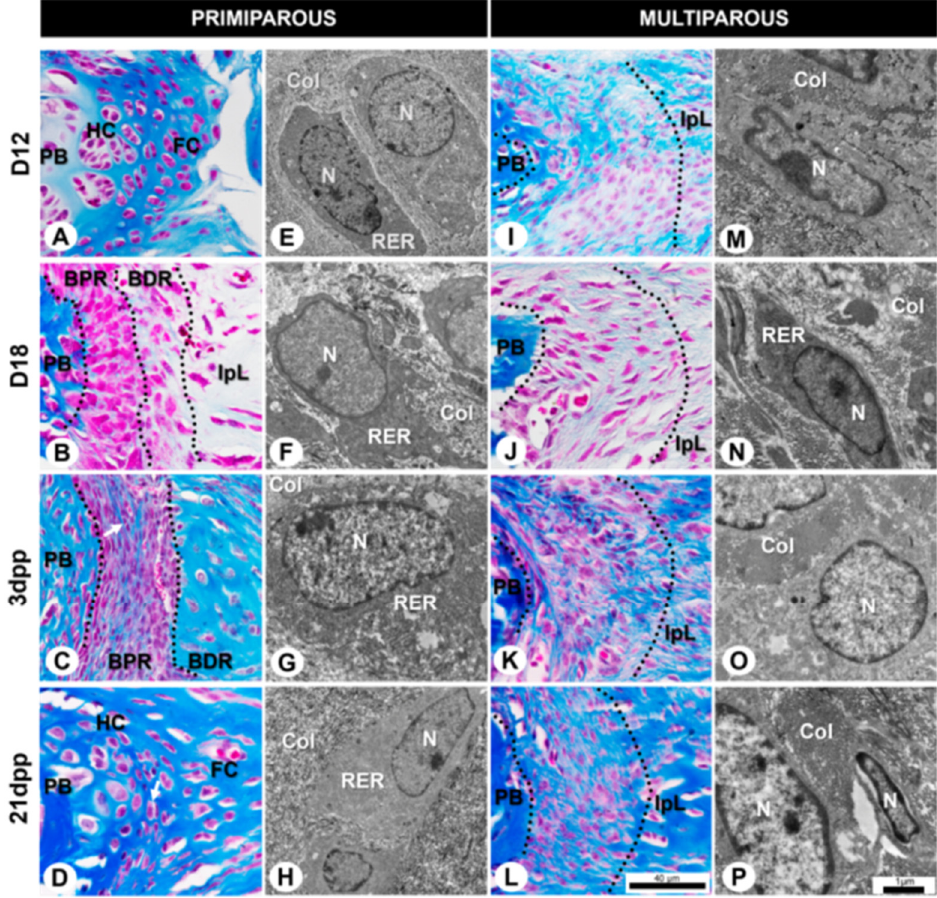
Figure 1. Representative cells and extracellular matrix (ECM) morphological aspects of symphyseal enthesis during pregnancy and postpartum in primiparous ( A – H ) and multiparous senescent ( I - P ) female mice at light and transmission electron microscopy. ( A ) At D12, pubic symphysis (PS) architecture is composed of the fibrocartilaginous disc (FC) between hyaline cartilage (HC). ( B , C ) At D18 and 3dpp, between pubic bones (PB) and interpubic ligament (IpL), see demarcated areas with dotted lines that approximately correspond to two distinct regions in the symphyseal enthesis: bone proximal region (BPR) with numerous oval cells next to each other and bone distal region (BDR) with elongated and sparse cells. ( D ) At 21dpp, the BPR and BDR of the enthesis are indistinguishable, and a similar non-pregnant joint morphology is restored. See the organization of cells around the PB and the isogenous groups (arrow). ( I – L ) Symphyseal enthesis of multiparous senescent mice with persistent IpL during pregnancy and postpartum. BDR and BPR are almost indistinguishable in demarcated areas with dotted lines. ( E – H , M – P ) Ultrastructure of symphyseal enthesis cell types and ECM aspects during pregnancy and postpartum in primiparous and multiparous senescent female mice. Observe the presence of a developed rough endoplasmic reticulum (RER) in the cytoplasm, nucleus (N), and collagen fiber (Col) arrangement. ( A – D , I – L ) Masson trichrome staining, scale bar = 40 µ m. ( E – H , M – P ) Transmission electron microscopy, scale bar = 1 µ m. At late pregnancy in primiparous female mice, the typical decrease in basophilia at the hyaline cartilage ECM and the development of fibrocartilaginous enthesis allow us to distinguish two distinct regions: the bone proximal region (BPR) and the bone distal region (BDR). The BPR is next to the PB and is composed of numerous rounded cells close to each other and loose chromatin (Figure 1B). The BDR connects the BPR and IpL and is